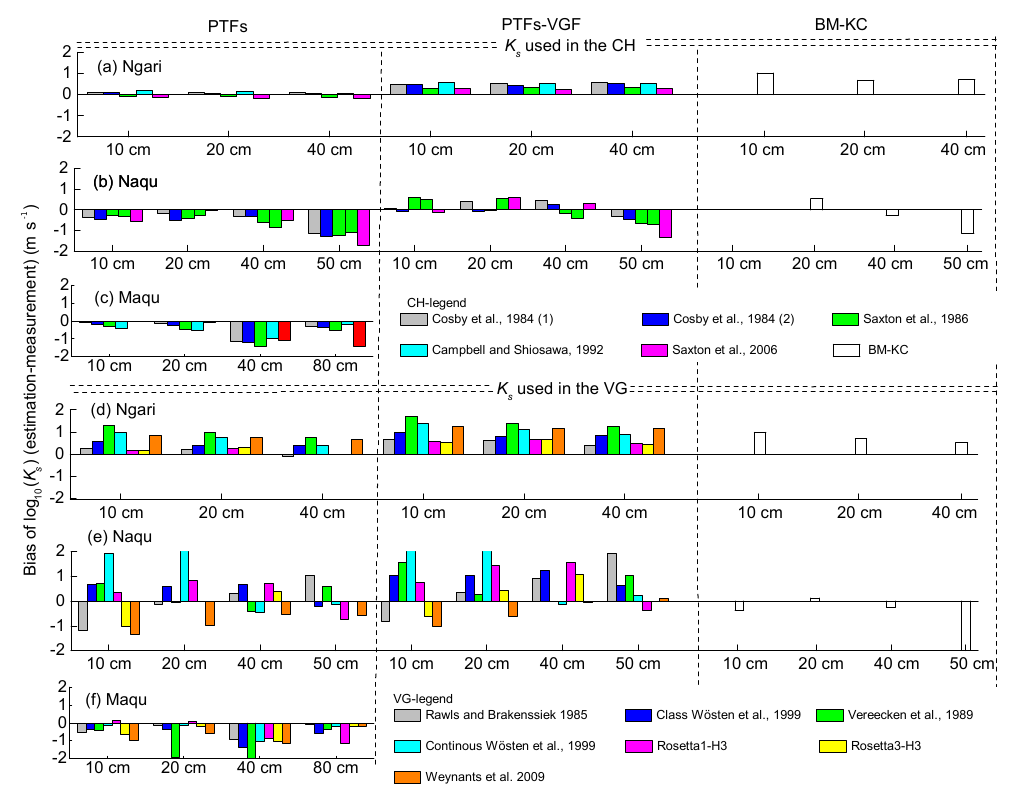
Figure 10. Comparisons of K s , derived from PTFs, PTFs–VGF and BM-KC schemes in the CH and VG models, with field measurements in the profile over three climate